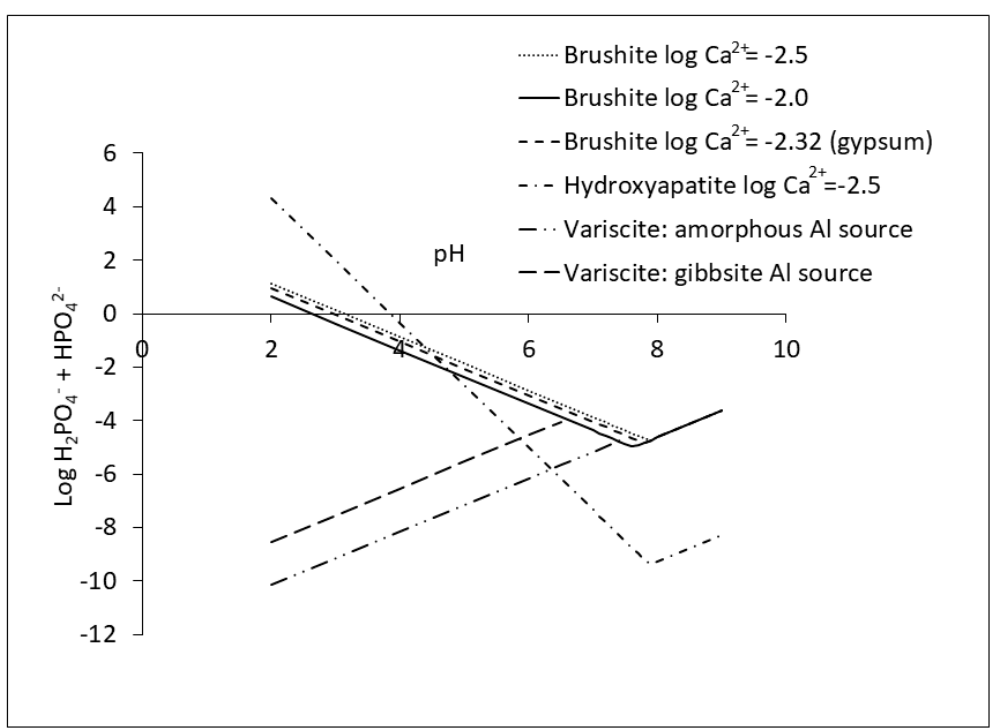
Figure 2. Solubility diagram for Al (variscite) and Ca (brushite and hydroxyapatite) phosphate minerals calculated with thermodynamic constants from Lindsay [47] and using different sources or concentrations of Ca 2+ and Al 3+ .